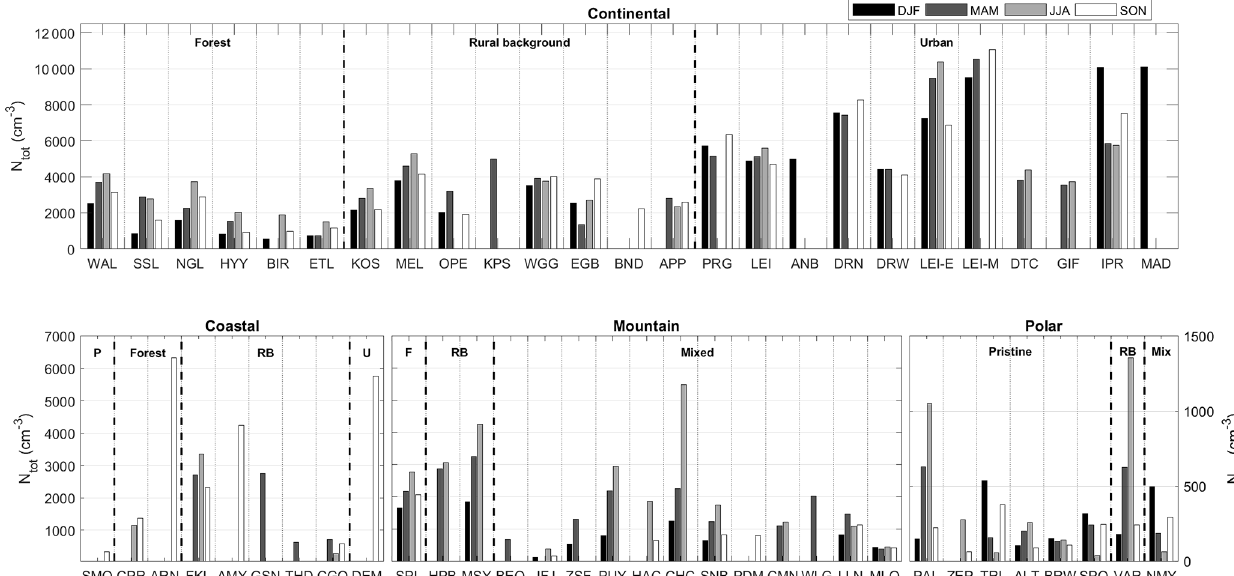
Figure 9. Seasonal medians of the total particle number concentration ( N tot ). Stations are grouped according to their geographical cate- gory and are further sorted based on their dominant footprint. For each site/season, statistics are only presented when corresponding data availability is > 75%. Note that the same scale is used for coastal and mountain